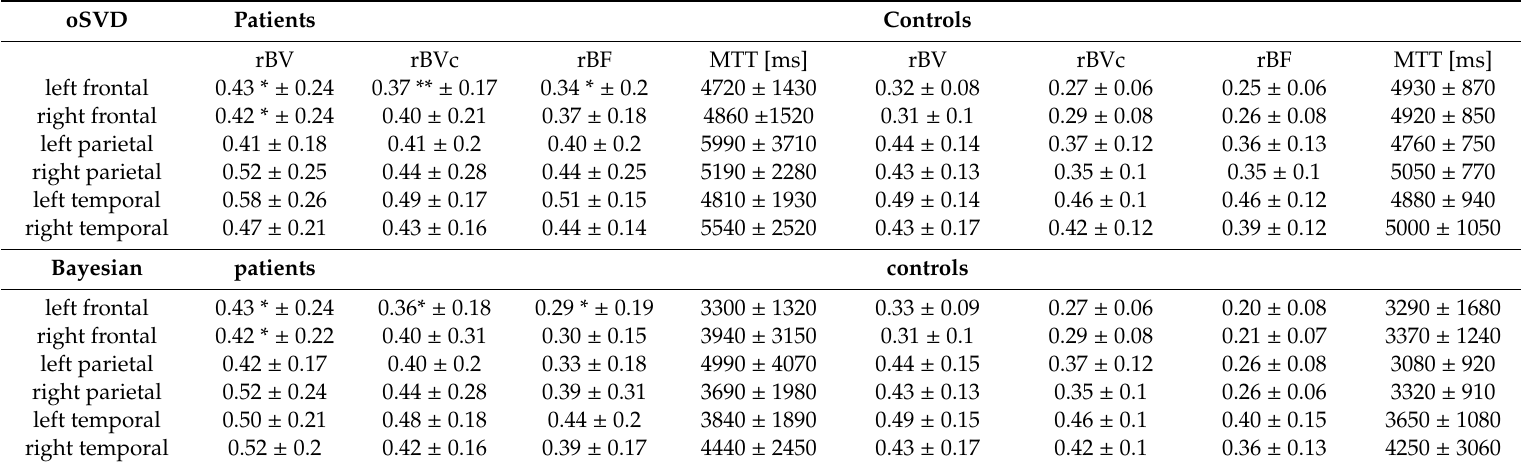
Table 3. Ratios of white matter / cortex perfusion values of relative cerebral blood volume (rBV), relative cerebral blood volume corrected for leakage (rBVc), relative cerebral blood flow (rBF) and the value of the cortical ROI of mean transit time (MTT)